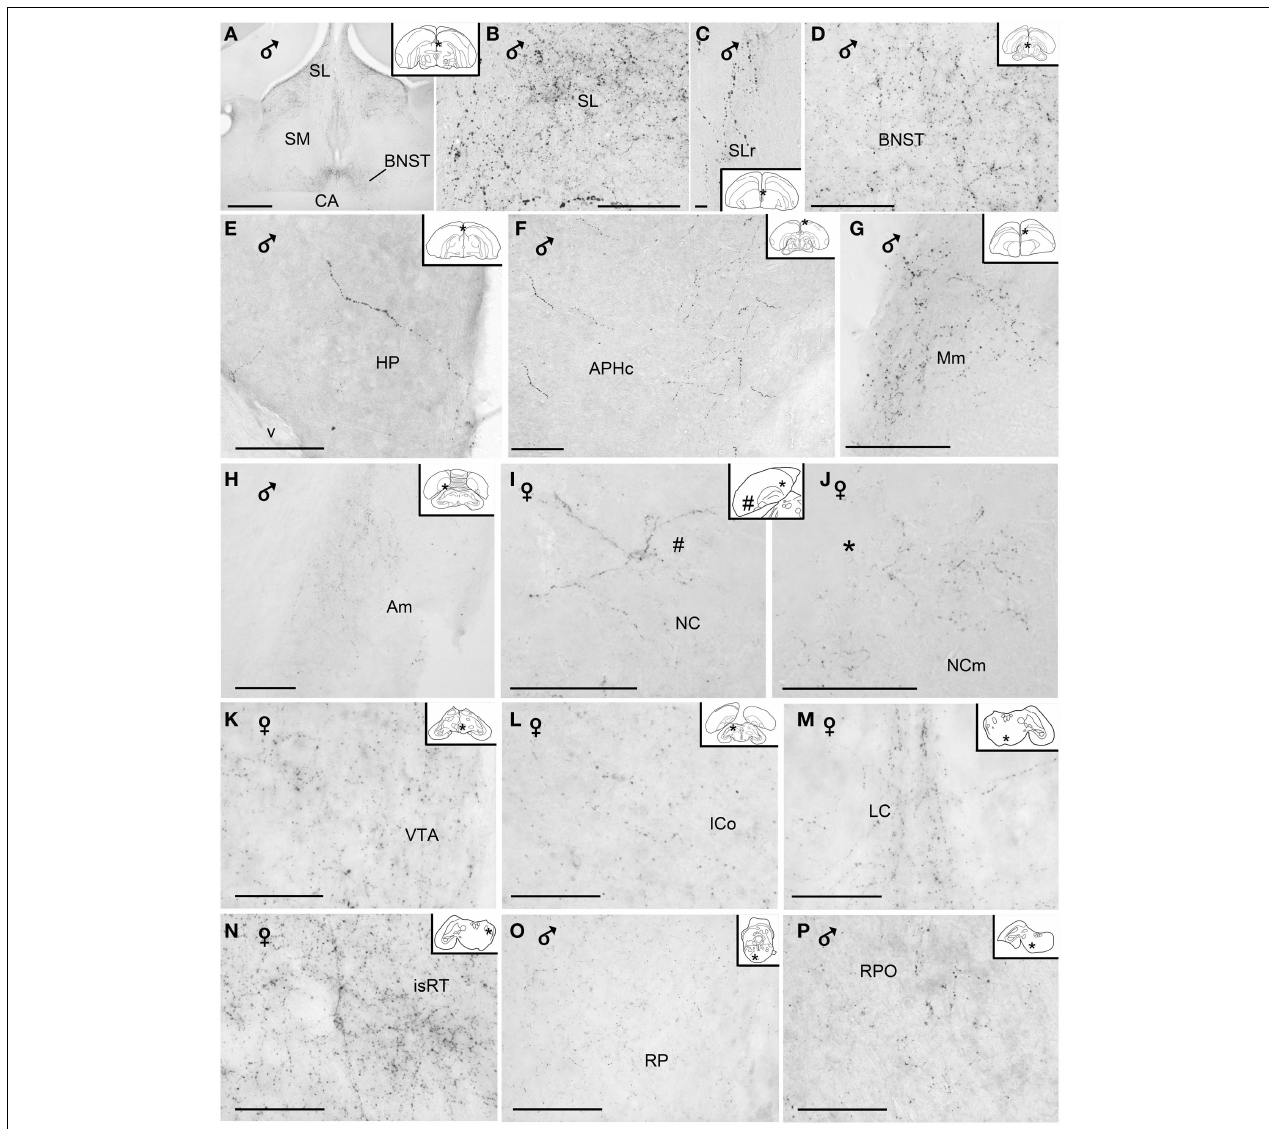
reticular nucleus. (Abbreviations in addition to those listed in the legend to Figure 1 : cAPH, caudal parahippocampal area; Mm, medial mesopallium; isRT, isthmic reticular formation; NC, caudal nidopallium; NCm, medial caudal nidopallium; RPO, oral pontine reticular nucleus; SLr, rostral lateral septum; v, ventricle). Inset: stars indicate the location of the photographed field on the topogram. On the joint topogram of (I,J) , the location of the photograph of (I) is marked by a #, and that of (J) by a * . These symbols also appear on the respective images. Calibration bar 100 µ m (A,B,D–P) , 10 µ m (C)